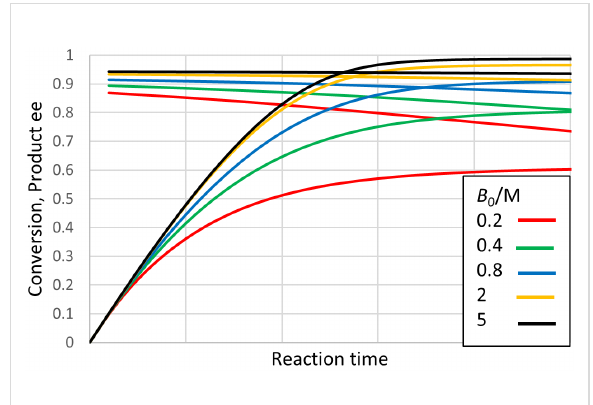
Figure 8: Progress curves for “ping-pong, both” kinetics, diacid esterifi- cation. The plot shows the increasing conversion of S and decreasing ee of the product. Parameters not changed: S 0 = 0.2 M, Q 0 = 0.5 M, K eq = 10, E = 39, K S = 0.1 M, k 2R = 1000 s − 1 , SCRf / b = 0.5, E2 / E = 0.5, SCR2f / SCRf = 1, SCSf / b = 1, k 4R / k 2R = k 2R / E · k 2S =